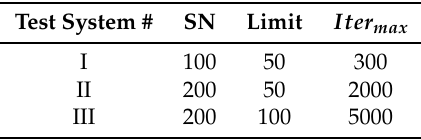
Table 5. Parameters of IABC for different test systems.